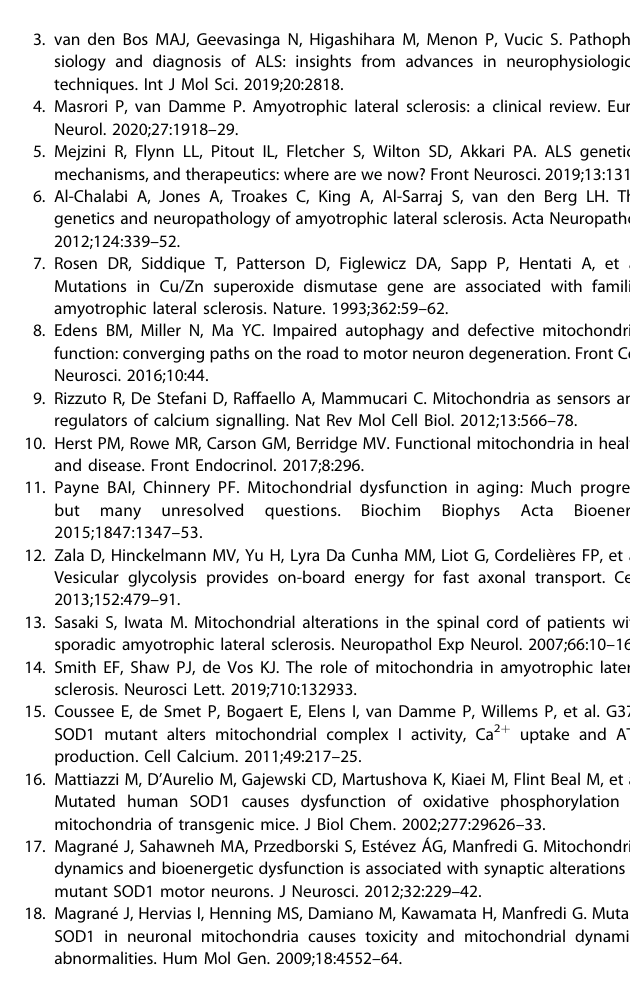
Fig. 6 Proposed model on the role of ERK1/2 and TSPO in ALS and their involvement in mitochondrial dysfunction. The activation of ERK1/2 signaling cascade in ALS is the sum of both external and internal stimuli and promotes TSPO overexpression via STAT3. It has been recently demonstrated that high levels of TSPO prevent the activation of mitophagy. At the same time, ERK1/2 contributes to the reduction of ET chain functioning. Notably, the enzymatic activity of ET chain is already compromised in ALS motor neurons by a sum of converging factors, including the accumulation of SOD1 G93A in the mitochondria and the lower levels of